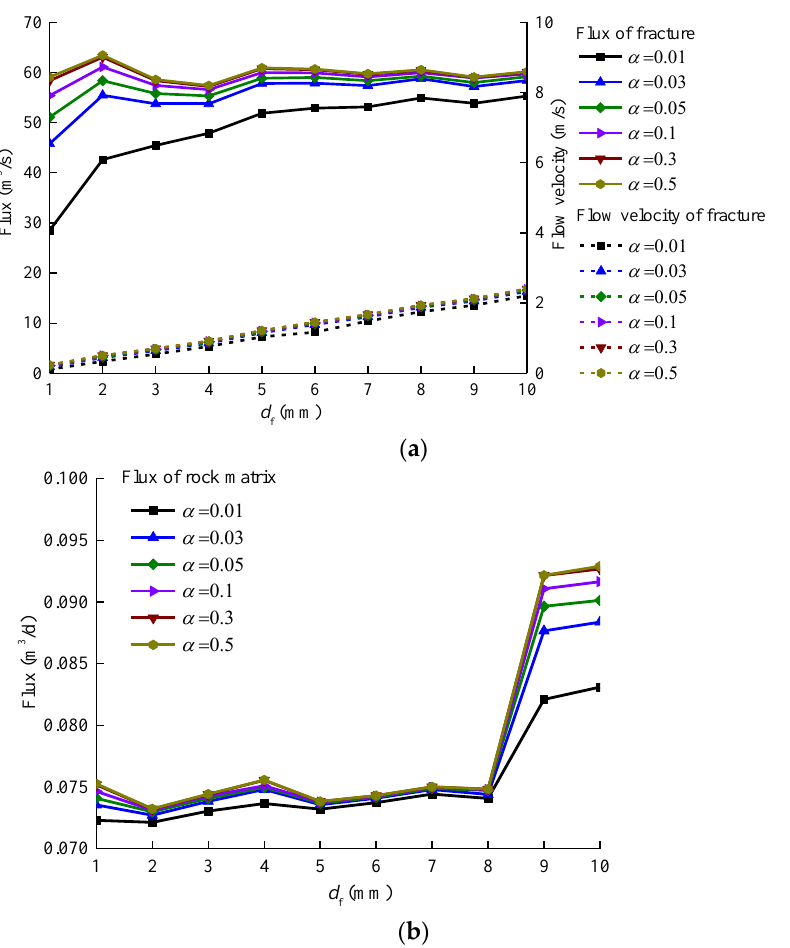
Figure 7. Flow velocity and flux through fractures in fractured rock mass with different apertures and different slip coefficients ( H = 3 m, d f = fracture aperture): ( a ) fracture and ( b ) rock matrix.